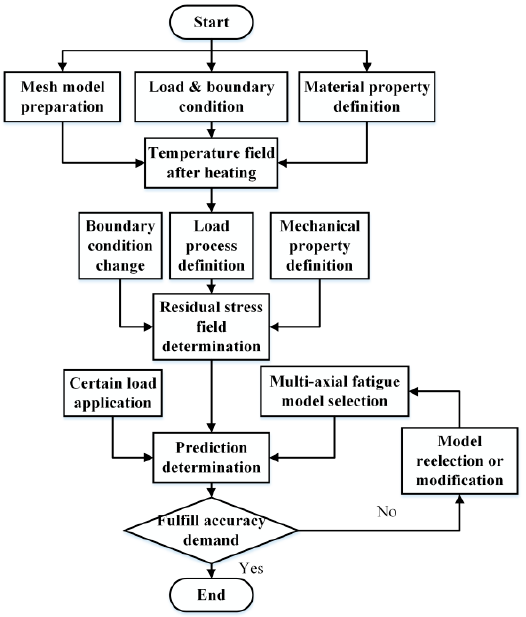
Figure 3. The research process of the paper.